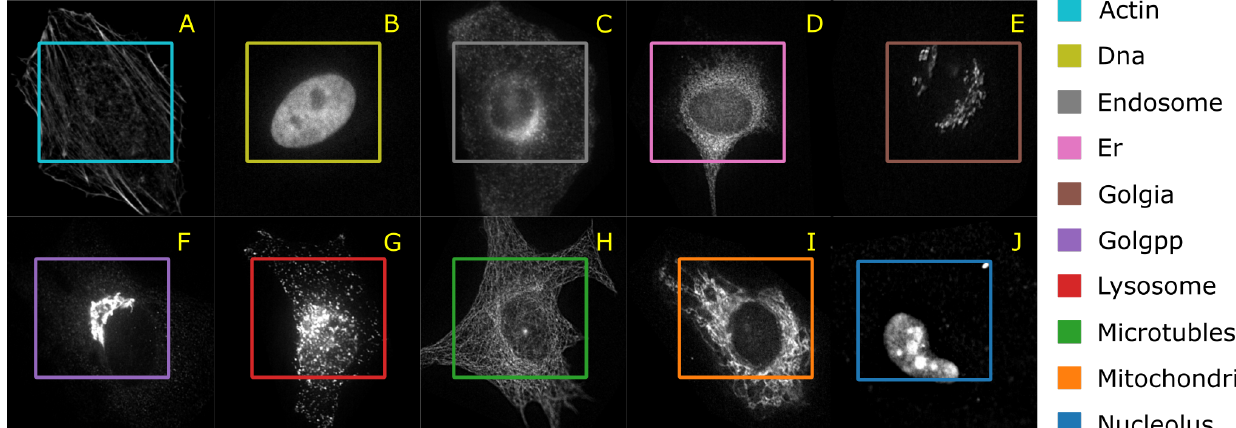
Figure 5. A representative image of each protein class and the average number of correctly classified instances in 10 cross validation ( A ) filamentous actin labeled with rhodamine-phalloidin (Actin); ( B ) DNA labeled with DAPI (DNA); ( C ) endoplasmic reticulum protein (ER); ( D ) transferrin receptor (endosome); ( E ) Golgi protein giantin (Golgia); ( F ) Golgi protein GPP130 (Golgpp); ( G ) lysosomal protein LAMP2 (lysosomes); ( H ) microtubules; ( I ) mitochondrial protein (mito- chondria); ( J ) nucleolar protein nucleolin (nucleolus).